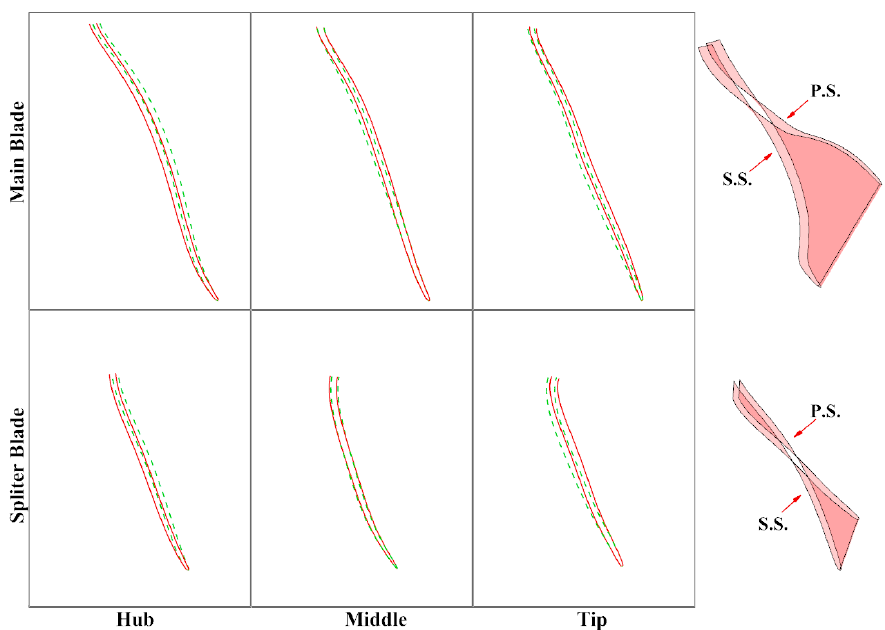
Figure 11. Comparison of the hub, middle and tip geometry before and after